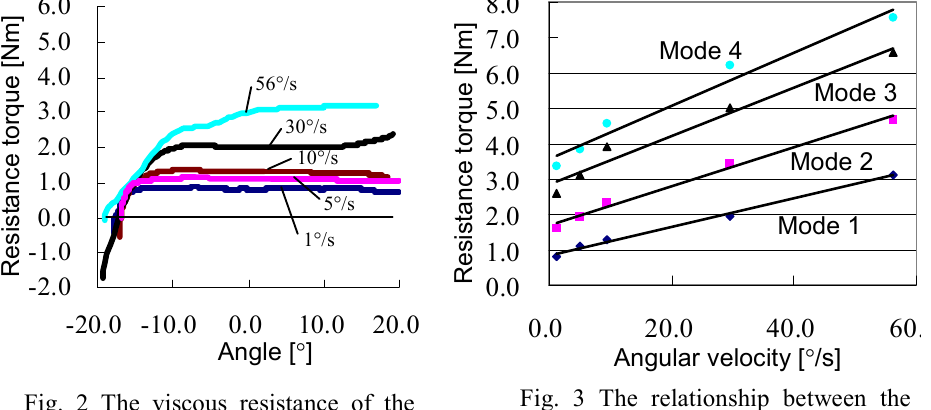
Fig. 2 The viscous resistance of the iAFO for mode 1 at angular velocities from 1° to